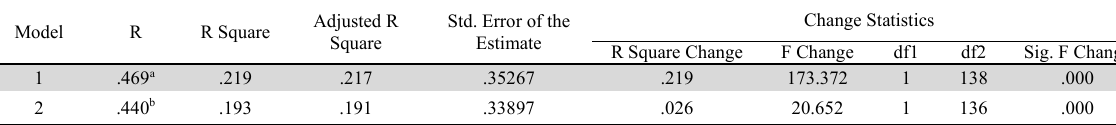
Model Summary c